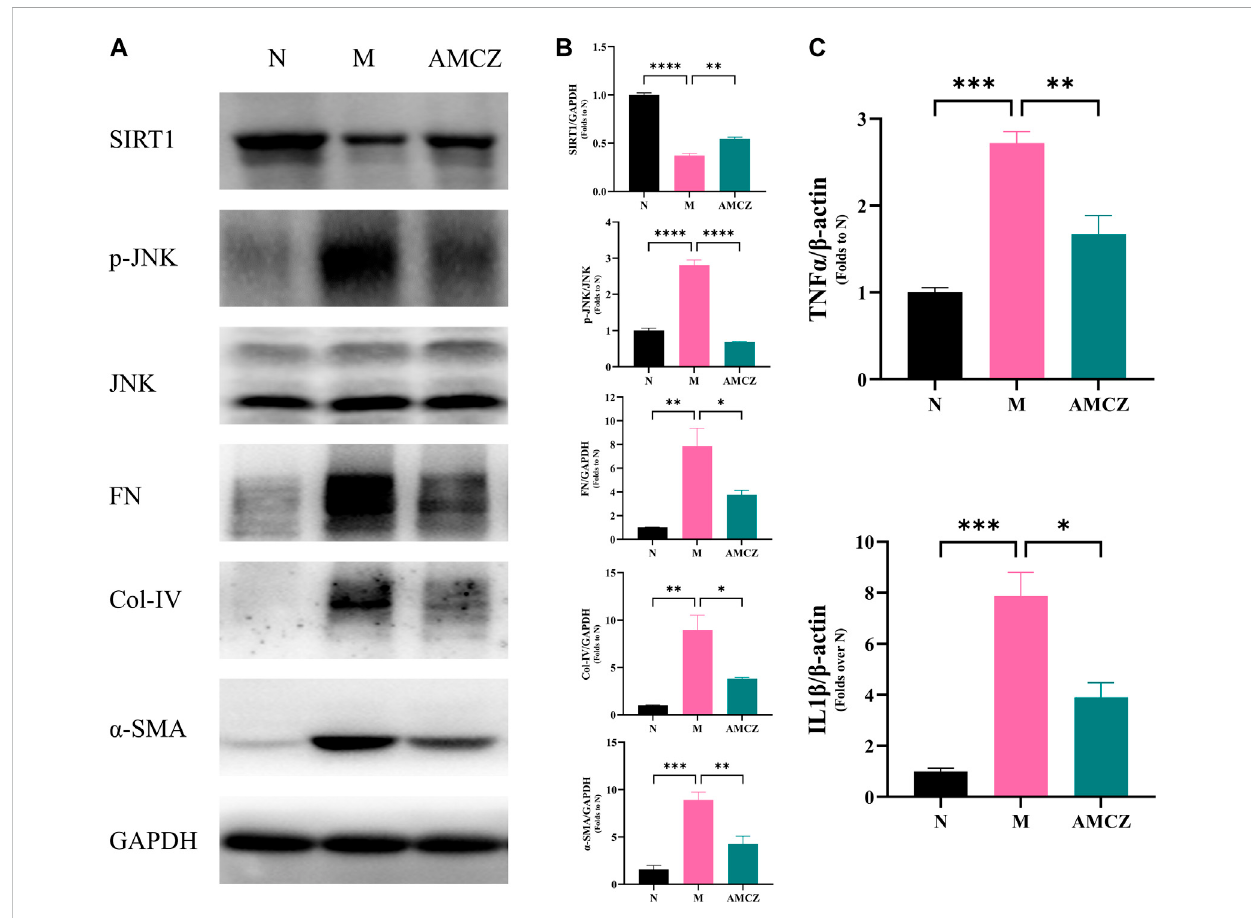
FIGURE 10 Effects of AM and CZ on SIRT1/JNK signaling pathway in adenine-induced CKD rats. (A) Representative Western blot images of SIRT1, p-JNK, JNK, FN, Col-IV, and α -SMA expression in the kidneys of rats. (B) Densitometric analysis of SIRT1, p-JNK, JNK, FN, Col-IV, and α -SMA normalized to GAPDH content. Values are expressed as mean ± SEM,n = 3 rats per group (* p < 0.05 ** p < 0.01,*** p < 0.001, and **** p < 0.0001 between the indicated two groups). The total RNA was isolated and subjected to real time RT-PCR to analyze the products of pro-in fl ammatory cytokines, IL-1 β and TNF- α in cortex tissues treated with AM and CZ. β -actin was used as an internal control (* p < 0.05 ** p < 0.01, and *** p < 0.001 between the indicated two